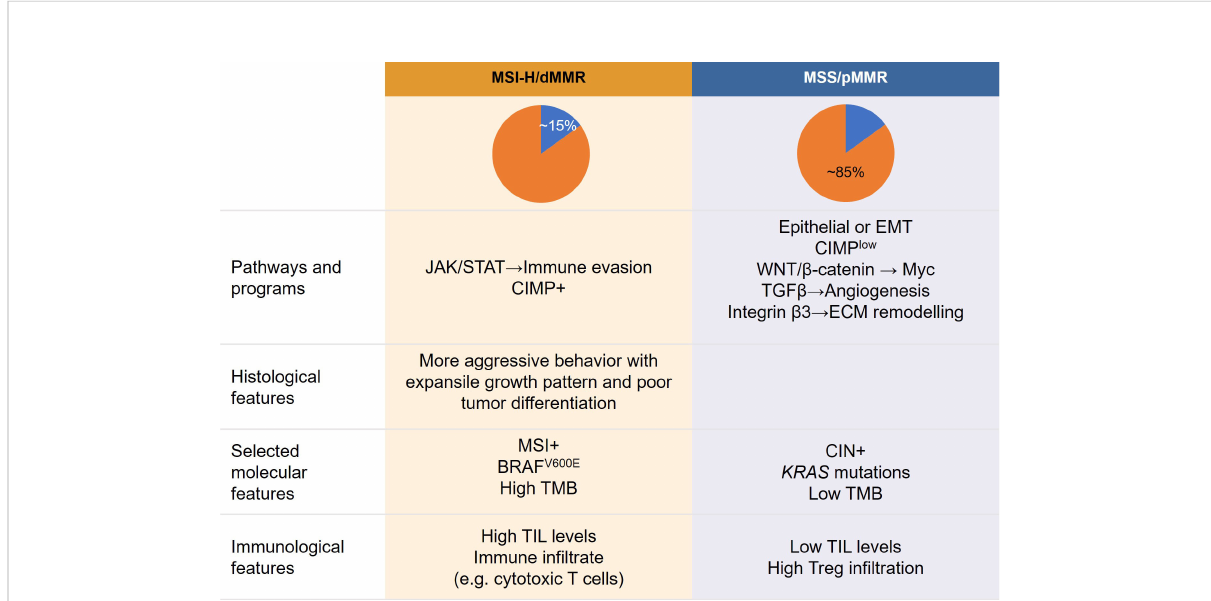
FIGURE 2 Proposed relationship between tumor features, molecular pro fi les, clinicopathological characteristics, and immunological features of colorectal cancer according to MSI subtype. CIMP, CpG island methylator phenotype; CIN, chromosomal instability; dMMR, mismatch repair de fi cient; ECM, extracellular matrix; EMT, epithelial – mesenchymal transition; JAK/STAT, Janus kinase/signal transducer and activator of transcription; MSI, microsatellite instability; MSS, microsatellite stable; pMMR, MMR pro fi cient; TGF, transforming growth factor; TIL, tumor-in fi ltrating lymphocyte; TMB, tumor mutational burden; Tregs, T-regulatory cells; VEGF, vascular endothelial growth